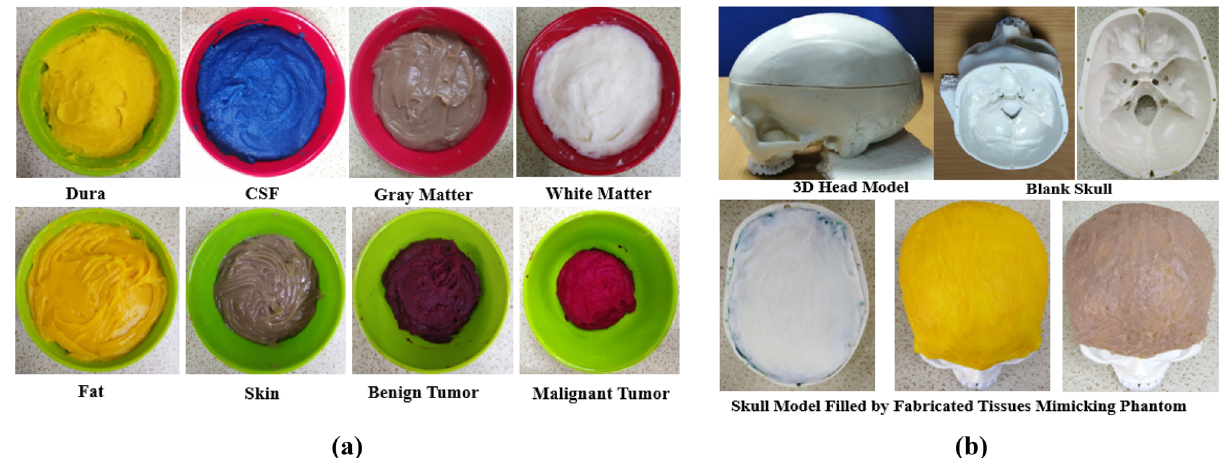
Figure 21. ( a ) Fabricated six tissue-mimicking phantom layers, including tumors; ( b ) 3D blank head model and skull model filled by fabricated tissue-mimicking